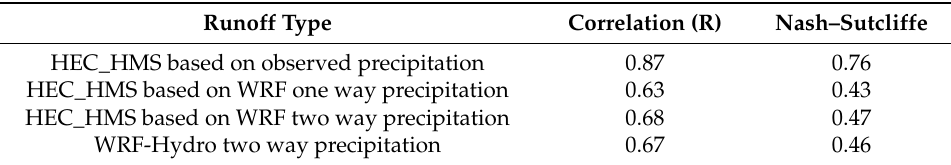
Table 3. Results for the Nash–Sutcliffe test and correlation for observed hydrograph for Ayalon–Ezra hydrometric station vs. simulate HEC-HMS hydrograph using observed precipitation as an input, HEC-HMS hydrograph using WRF-Hydro one and two way simulated precipitation as an input and WRF-Hydro two way hydrograph for the period 6 January 2015 to 17 January 2015.